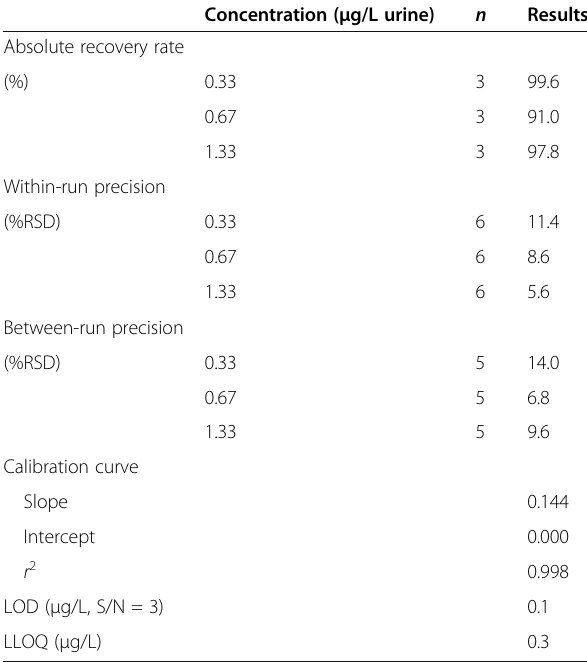
Table 4 Precision, recovery rate, linearity, LOD, and LLOQ data of the analytical procedure